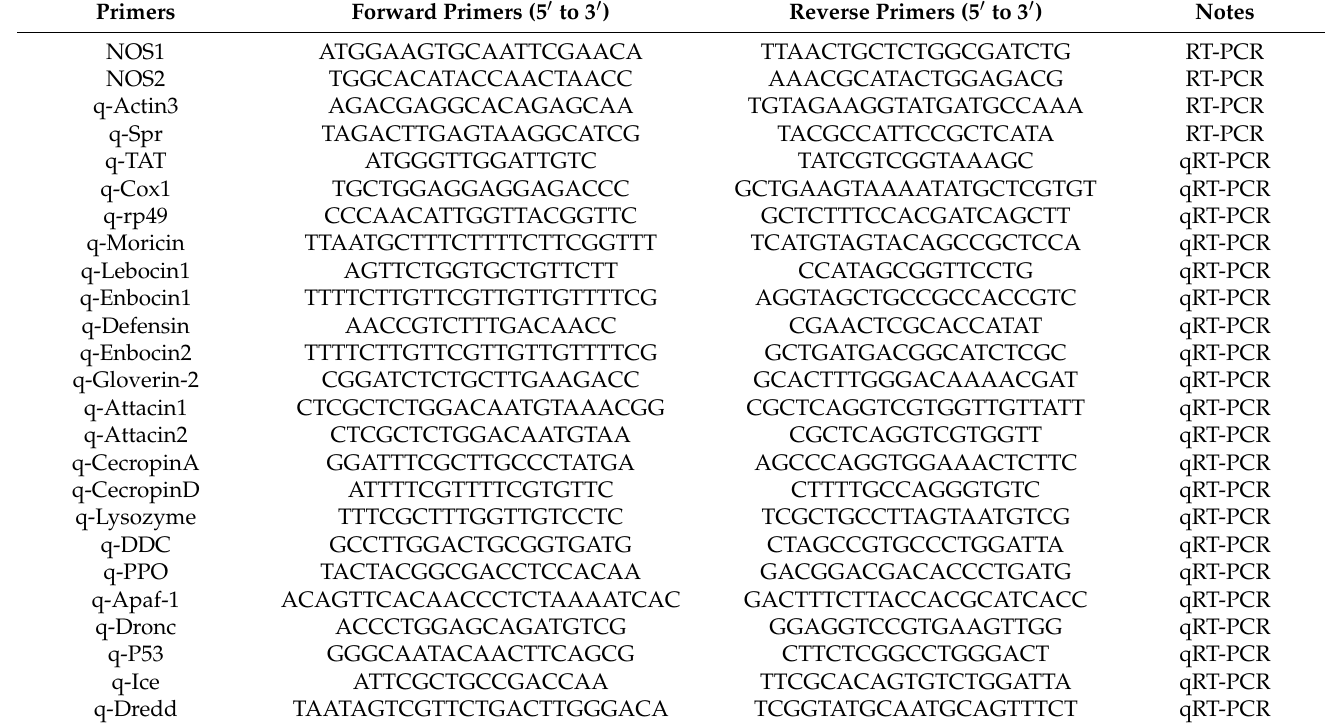
Table 2. Primers used in this